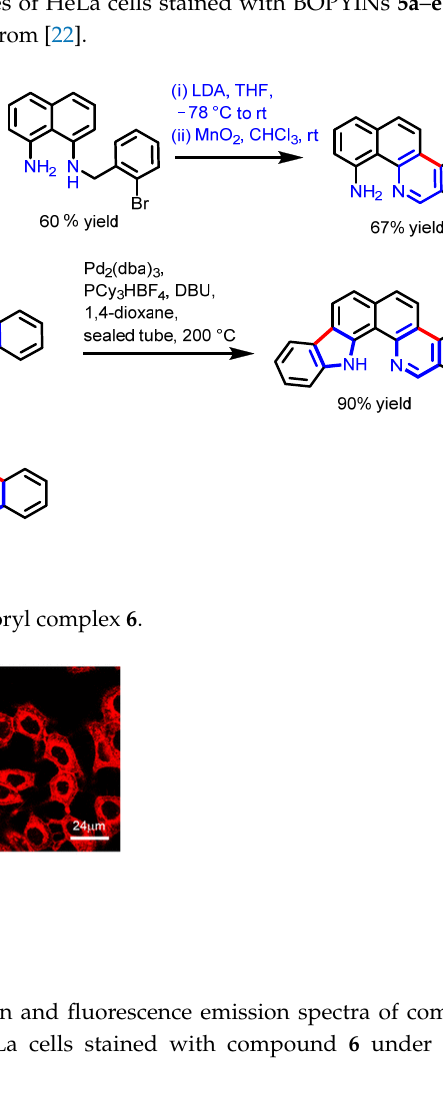
Figure 5. Confocal fluorescence images of HeLa cells stained with BOPYINs 5a – e under a green channel (488 nm) and blank. Adapted from [22].